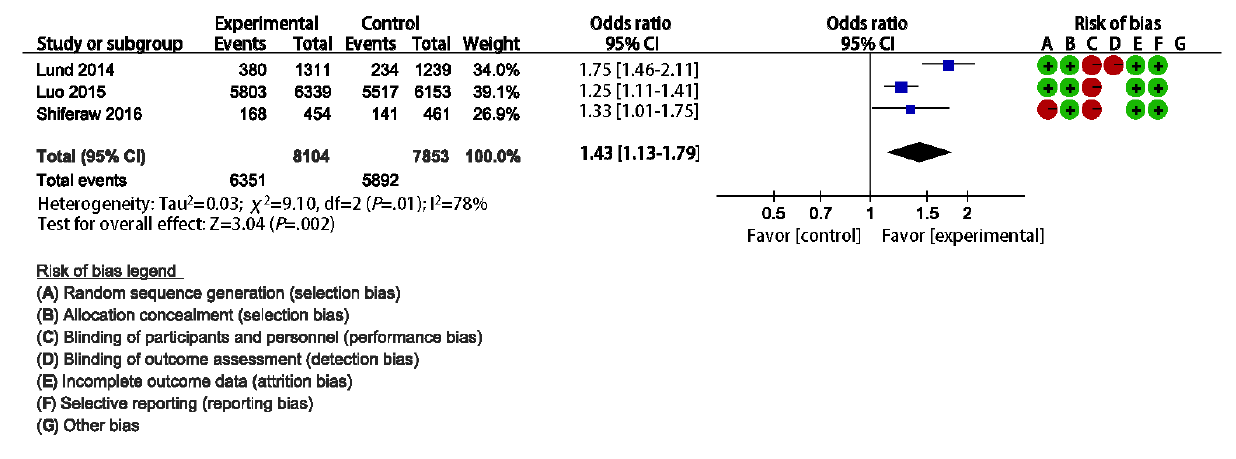
Figure 4. Meta-analysis of the effect of mHealth intervention versus routine prenatal care on four or more antenatal check rates based on three studies undertaken in Zanzibar, China, and